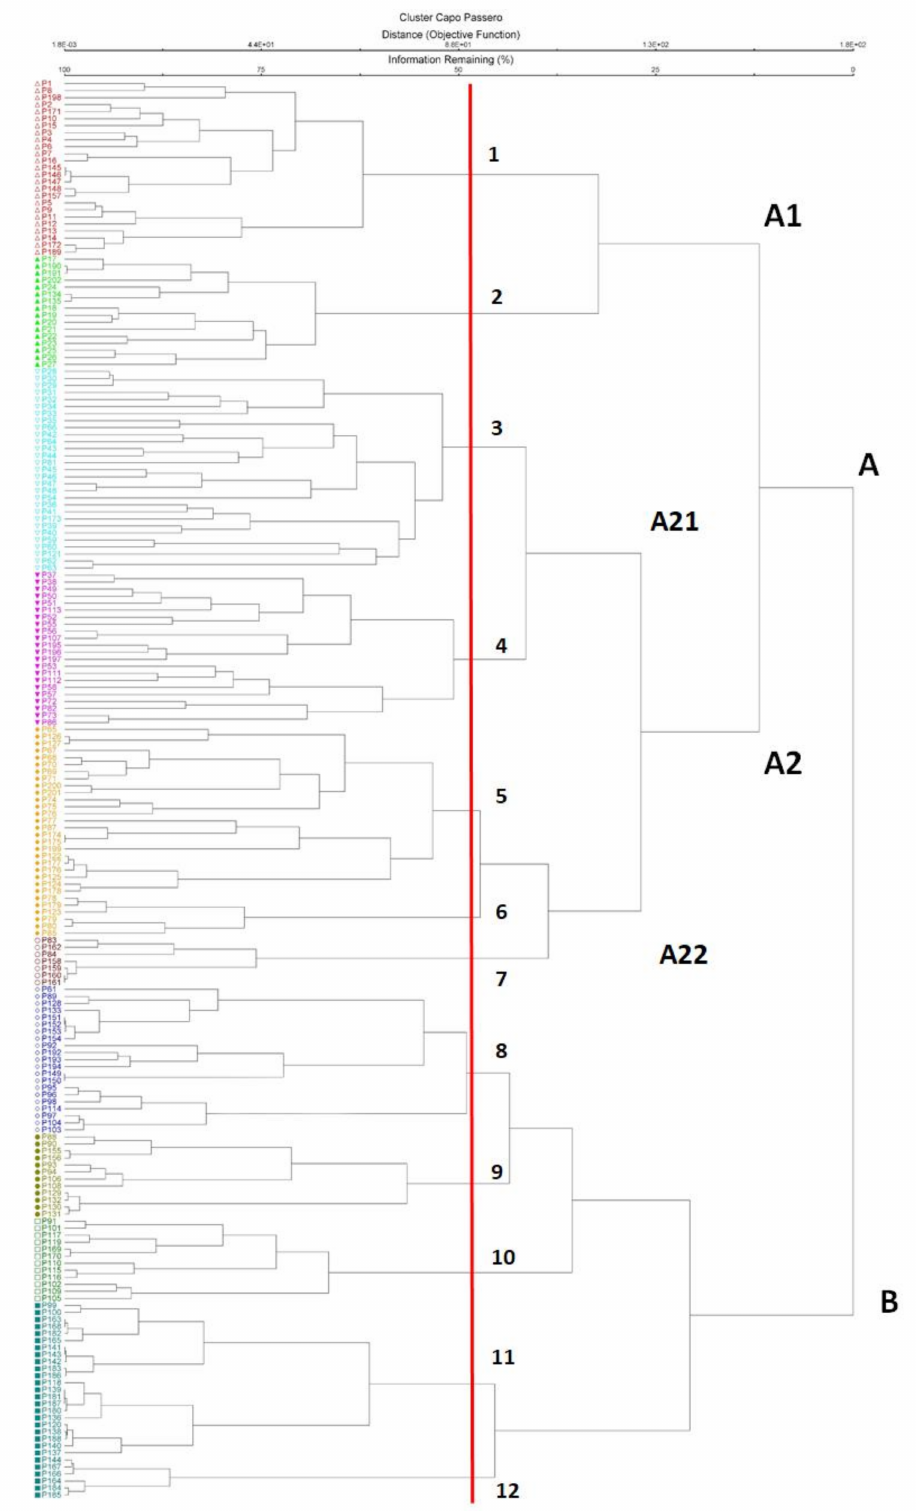
Figure 4. Cluster analysis of the surveyed plant communites: 1. Pistacio lentisci-Chamaeropetum humilis; 2. Chamaeropo humilis-Sarcopoterietum spinosi ; 3. Stipellula capensis and Asteriscus aquaticus community; 4. Parapholido incurvae-Catapodietum balearici ; 5. Centaureo sphaerocephalae-Ononidetum ramosissimae ; 6. Medicagini marinae-Ammophiletum australis ; 7. Salsolo- Cakiletum maritimae ; 8. Limonietum hyblaei ; 9. Spergulario bocconei-Mesembryanthemetum nodiflori ; 10. Crithmo maritimi- Limonietum virgati ; 11. Limonio virgati-Arthrocnemetum macrostachyi ; 12. Halimiono portulacoidis-Suaedetum verae